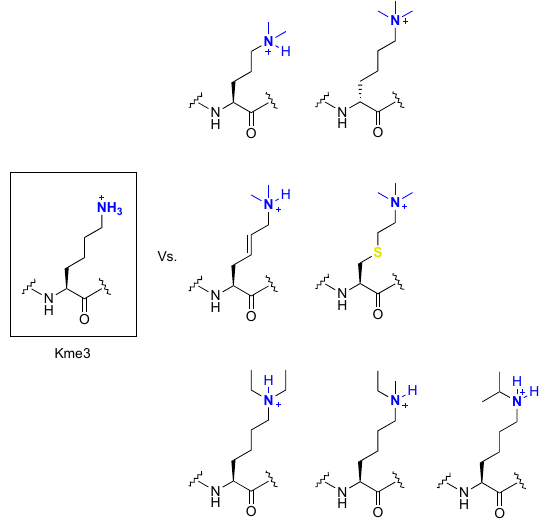
Figure 14. Kme3 analogues used in examinations by histone lysine demethylases.